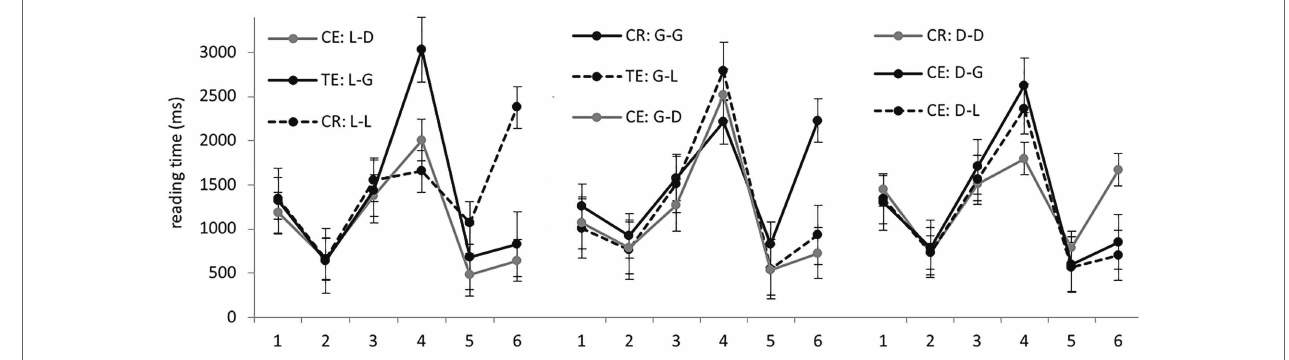
FIGURE 2 | Group 1: average RTs per region (in ms) in the nine experimental